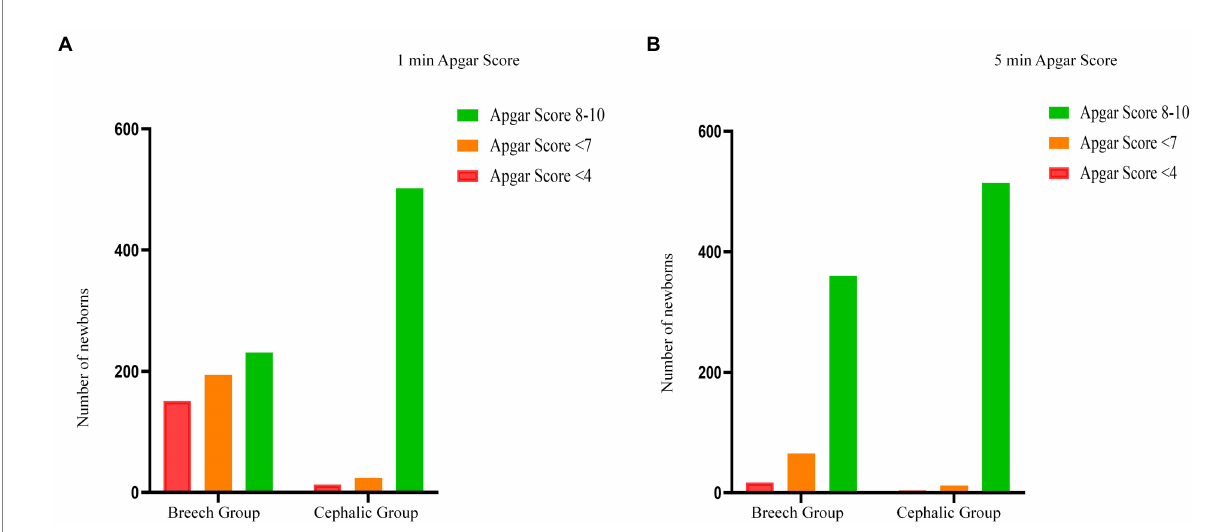
FIGURE 6 Apgar score between breech and cephalic presentation. This compared the one-minute and five-minute Apgar score in the breech group with that in the cephalic group. The number of Apgar scores <7 at 1 min and 5 min in breech group was significantly higher than that in cephalic group ( p < 0.01, p < 0.01, respectively). And the number of Apgar scores <4 at 1 min and 5 min in breech group was also significantly higher ( p < 0.01, p < 0.01,